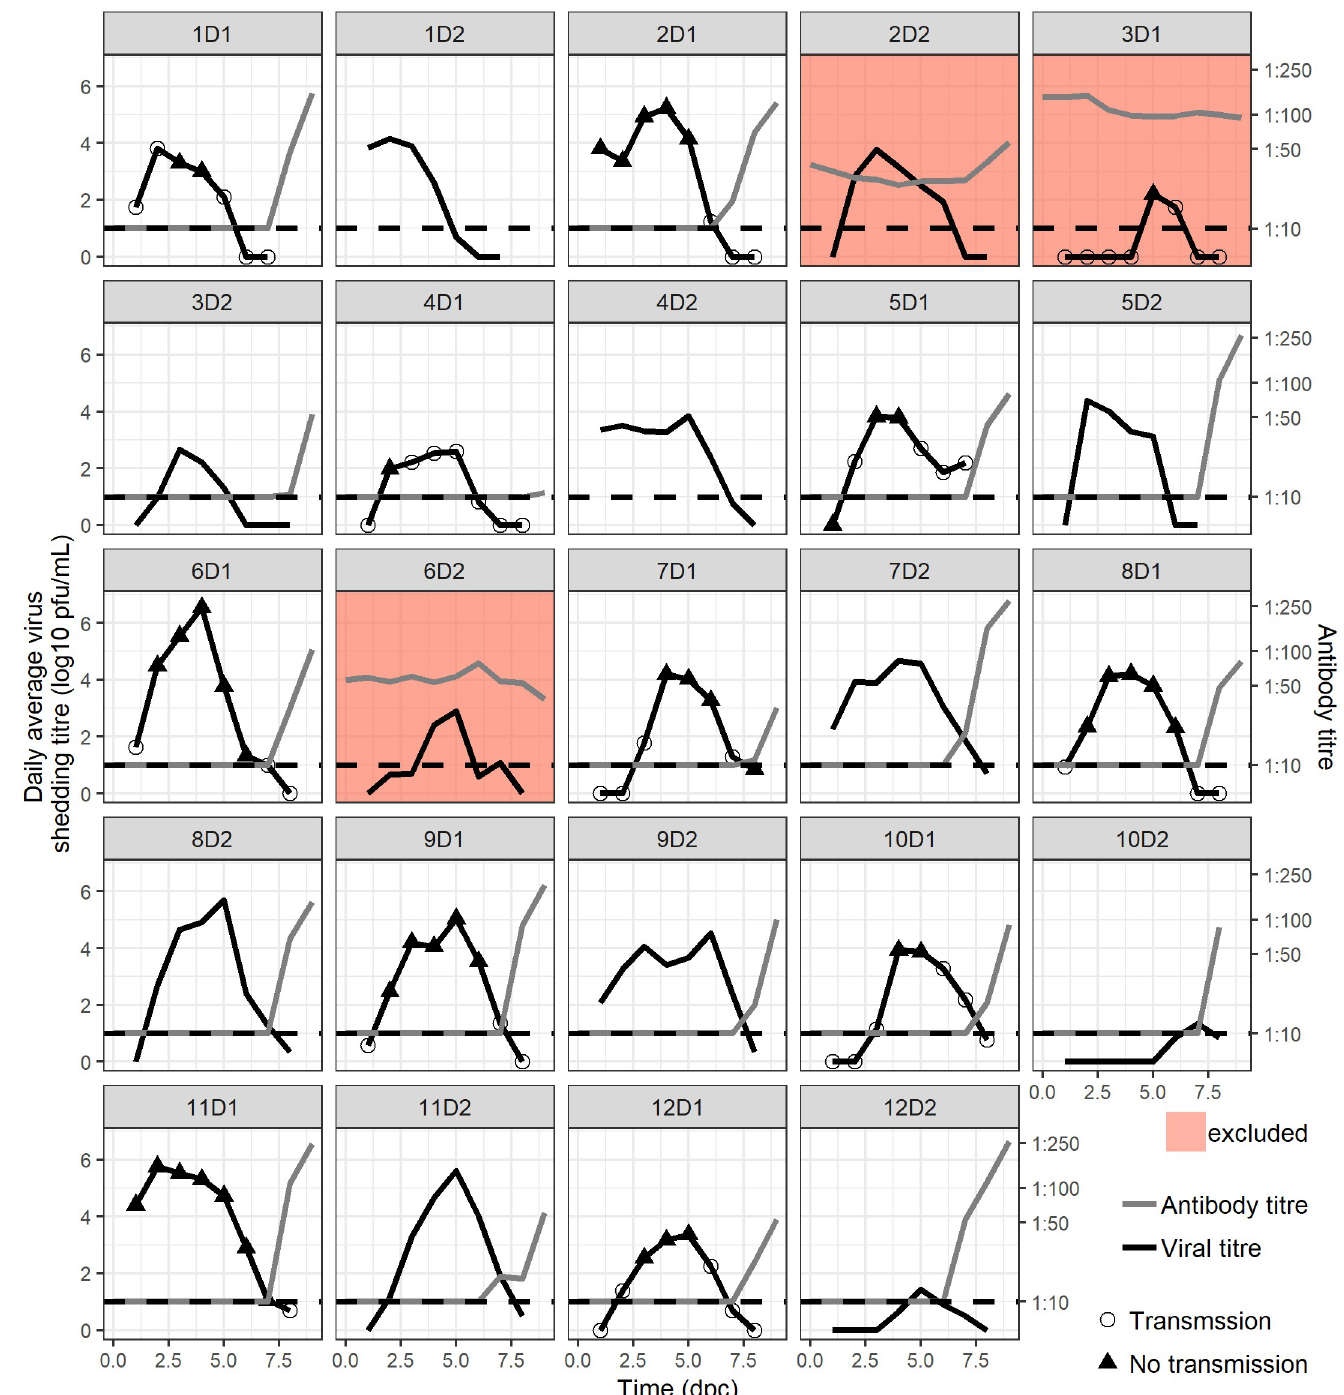
Fig 3. Individual donor and recipient pigs’ infection kinetics. Each box represents a donor pig. The viral kinetics is represented by a black line. Black triangles represents the average daily shed virus titres on days with transmission event and open circles represent the average daily shed virus titres on day without transmission events. The time since separation of seeder and donor is shown on the x axis. Antibody titers are represented by the grey line. The red filled boxes represent the pigs with baseline antibodies that were excluded from the analysis.